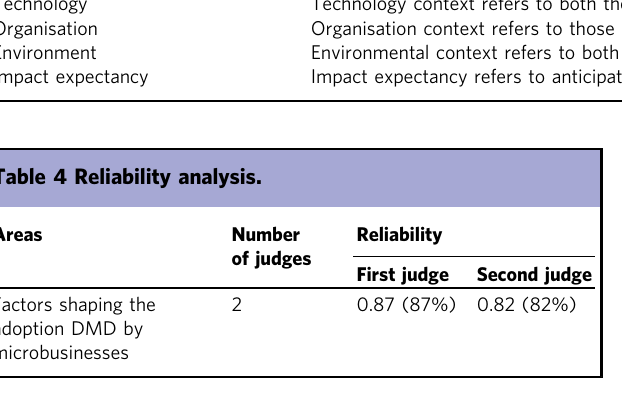
Table 3 Guide for a description of codes. Technology